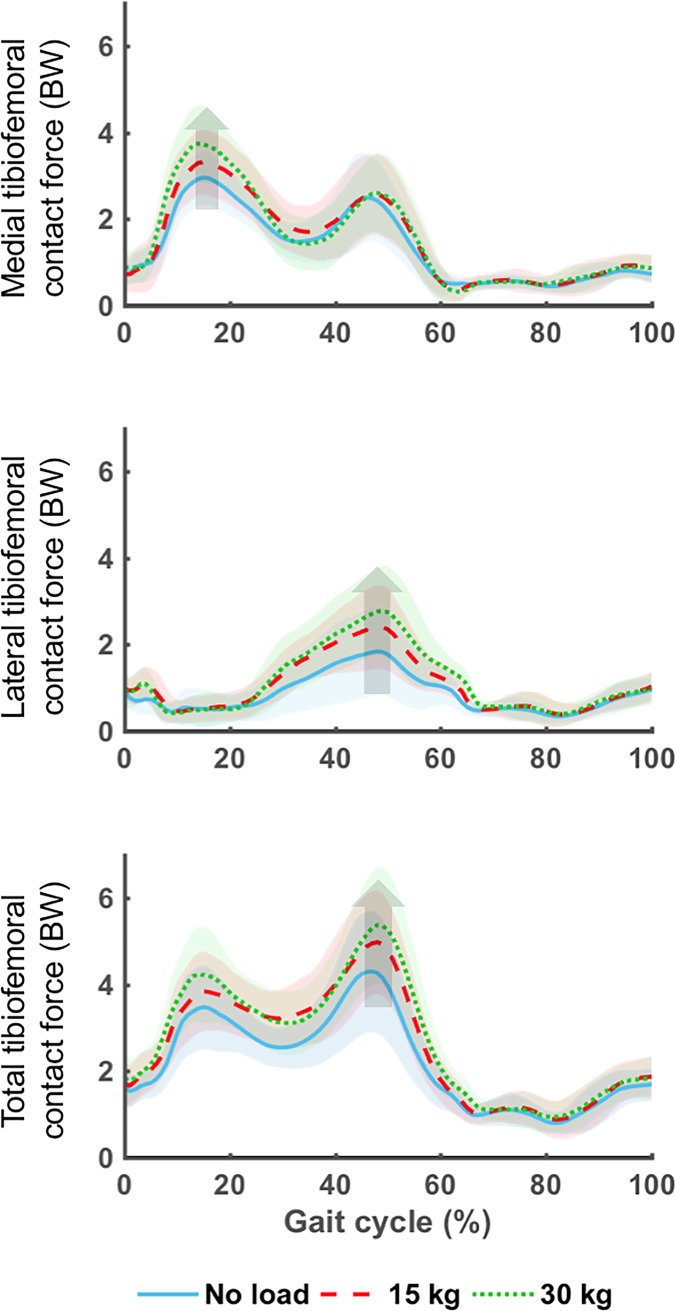
Mean (lines) and standard deviation (shaded region) medial, lateral, and total tibiofemoral contact forces for the unloaded, 15 kg, and 30 kg load conditions normalized to a gait cycle.Data for all loads were aggregated for walking speed. Arrows indicate significant increases in peak contact force with increasing load.